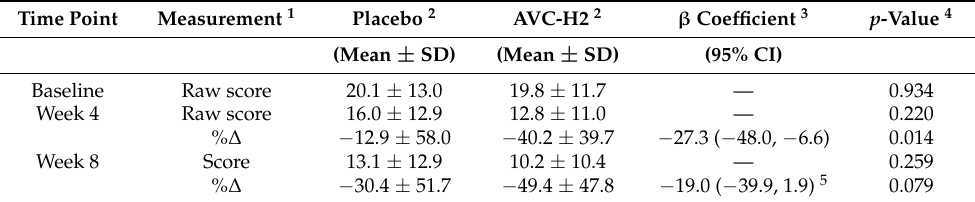
Table 5. WOMAC sub-score in the difficulty in physical activities domain from the baseline to the follow-up